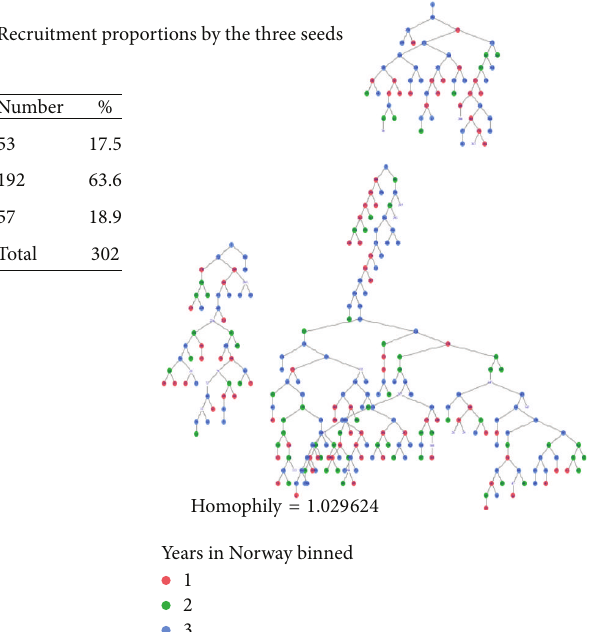
Figure 1: Recruitment chain by duration of stay in